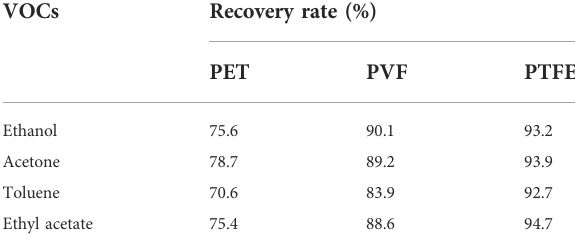
TABLE 2 VOC recovery rates at equilibrium.